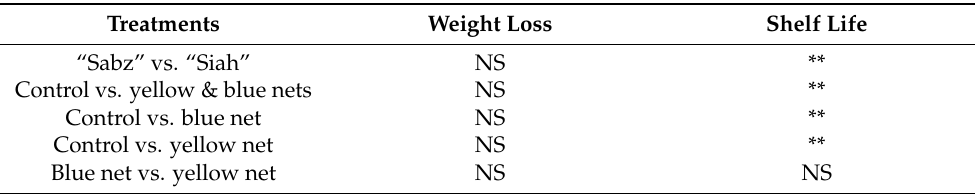
Table 5. Orthogonal contrasts between cultivars and net color in fig